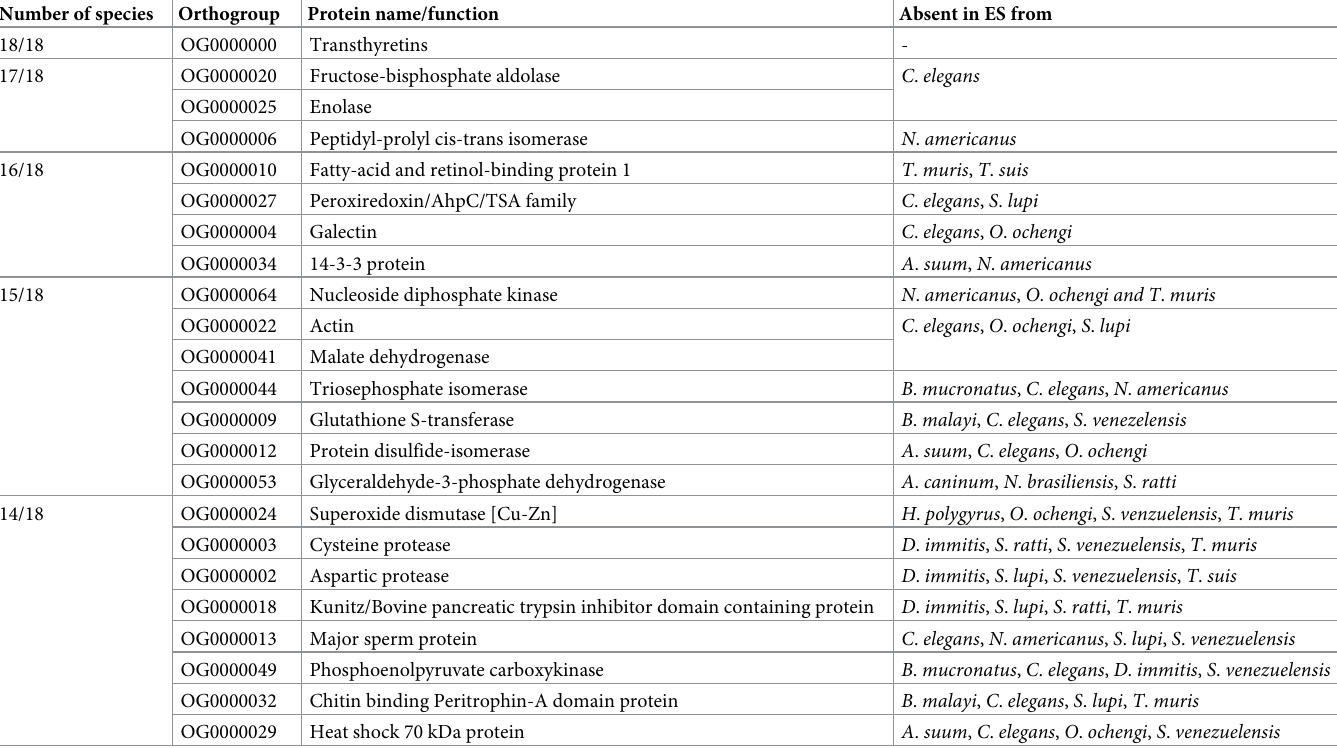
Table 3. Most common ESPs based on orthology analysis. ESPs were assigned to orthogroups in OrthoFinder. The number of species where at least one protein was assigned to a given orthogroup is indicated, along with the species where the orthogroup was found to be absent. Number of species Orthogroup Protein name/function Absent in ES